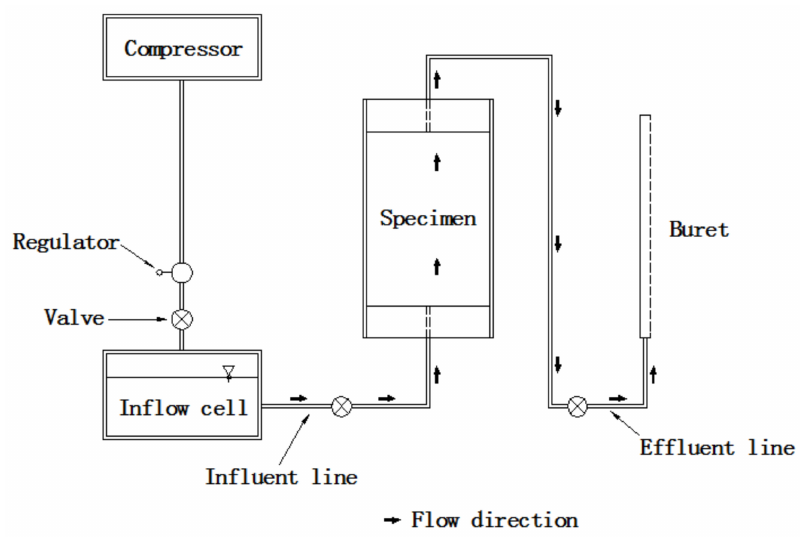
Figure 4. Rigid wall permeameter for hydraulic conductivity